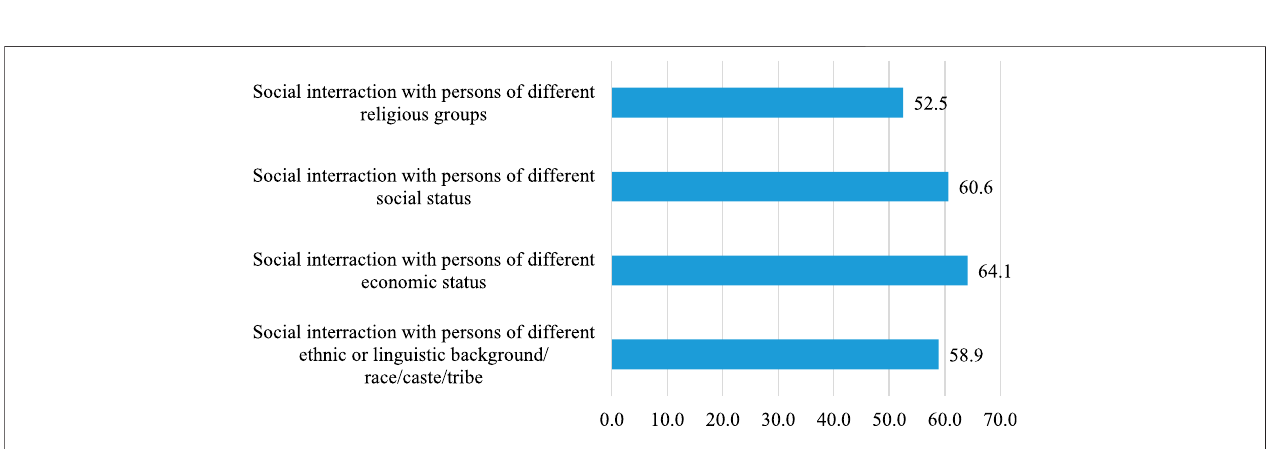
FIGURE 3 | Percentage distribution of bridging social interactions among SSA migrants in Germany ( N (cid:1) 518).